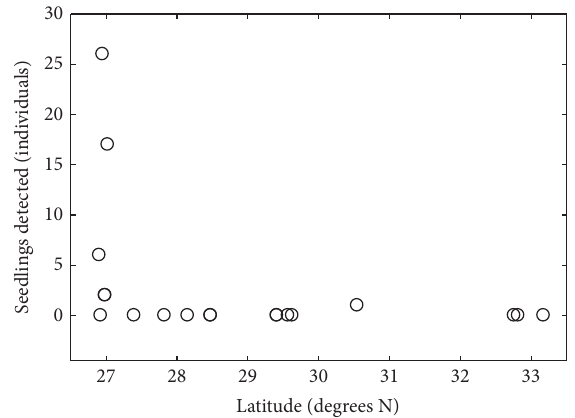
F 2: Eucalyptus seedling detections from all sites surveyed in this study.